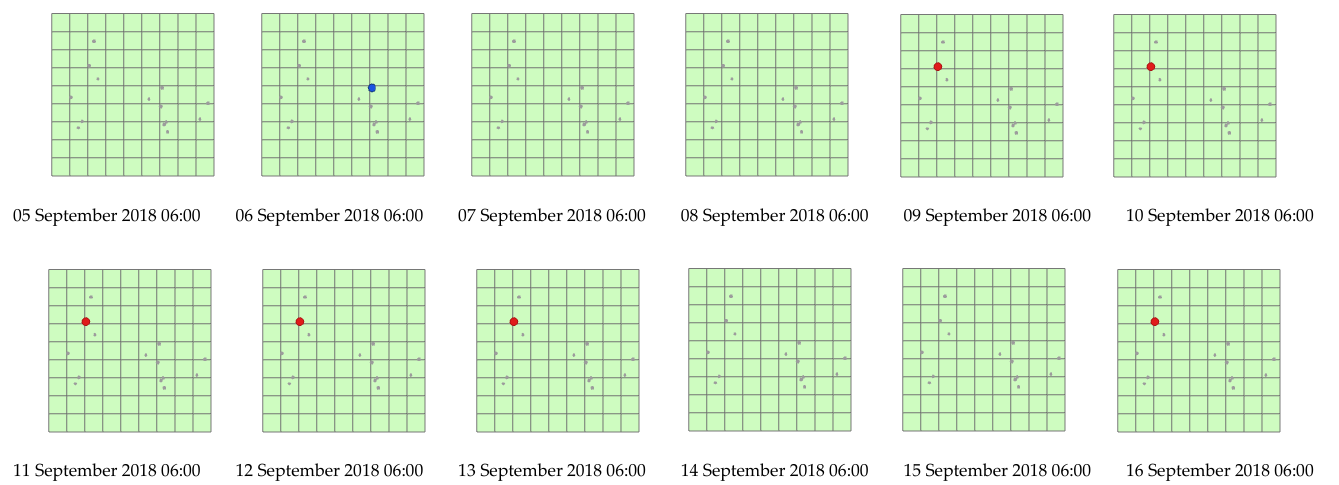
Figure A1. Spatial autocorrelation exists in grid 2. Red points represent high values surrounded primarily by low values (high–low outliers), and blue points represent low values surrounded primarily by high values (low–high outliers), which are two typical cluster types of spatial autocorrelation.